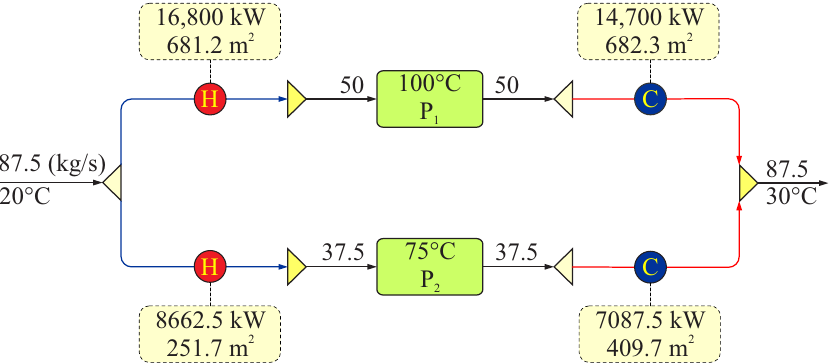
Figure 2. Base case for the motivation example without water and heat